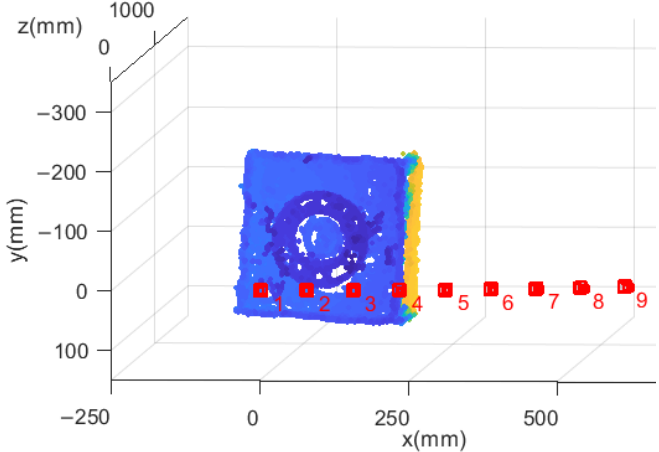
Figure 9. Satellite 3D feature point model.